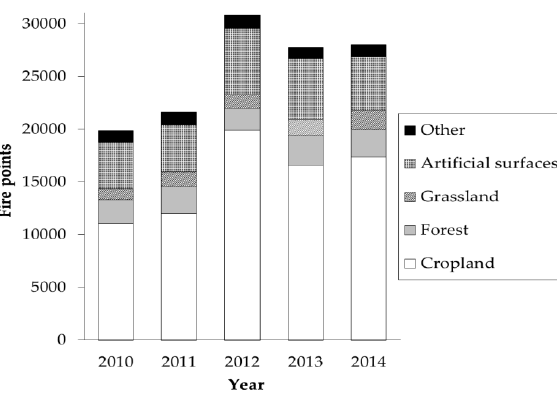
Figure 2. Fires in China occurring on the predominant land cover types from 2010 to